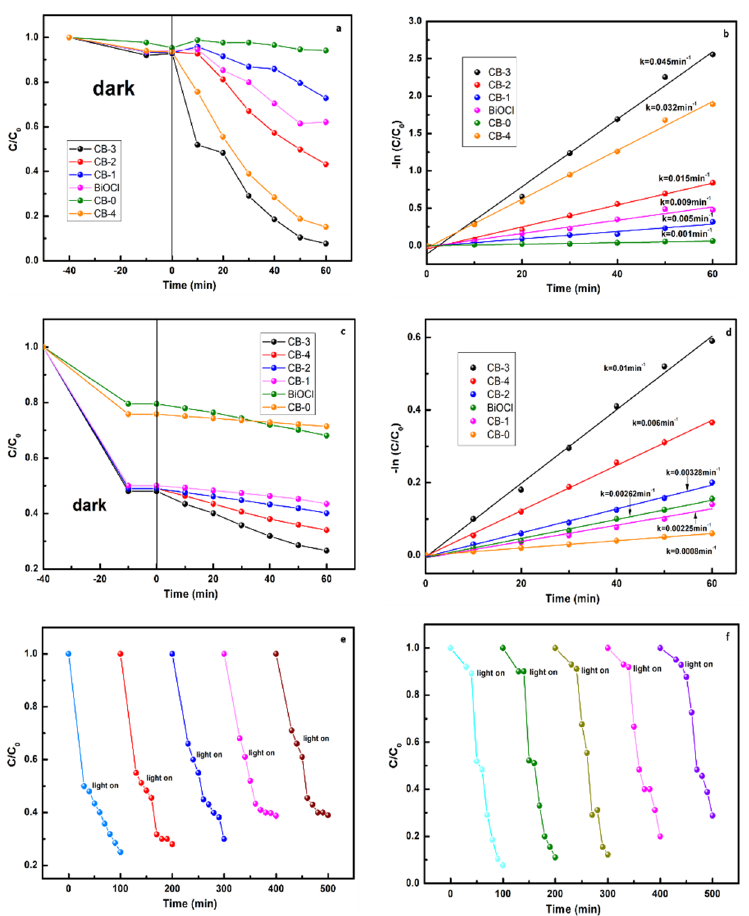
Figure 8. ( a ) Photodegradation efficiency of RhB, ( b ) pseudo-first-order kinetic model, ( c ) pho- todegradation efficiency of MO, ( d ) pseudo-first-order kinetic model, ( e ) reusability test of CB-3